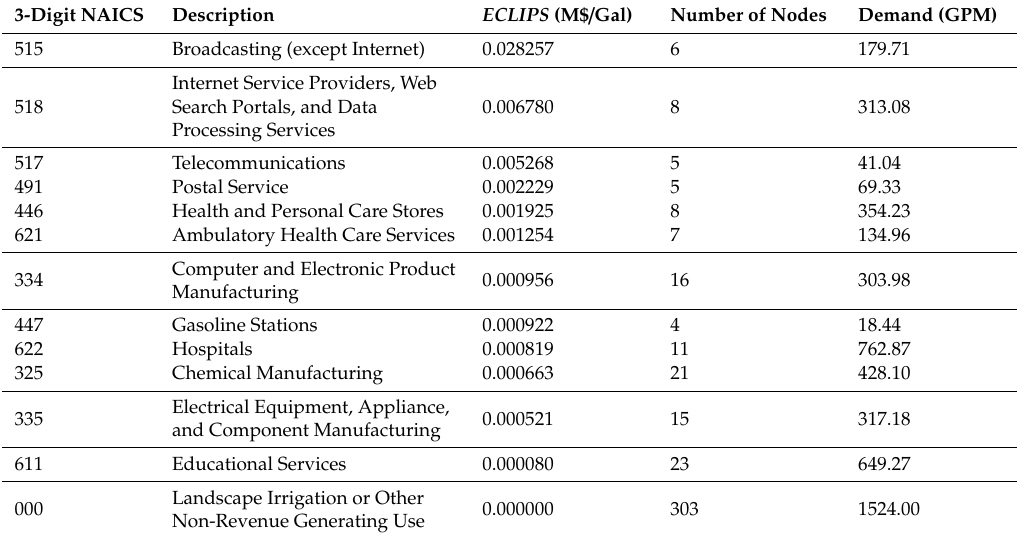
Table 1. Candidate NAICS code for U-City and water cost information, number of the EPANET model nodes serving the NAICS code, and total demand for the nodes serving the NAICS code following Lee et al.